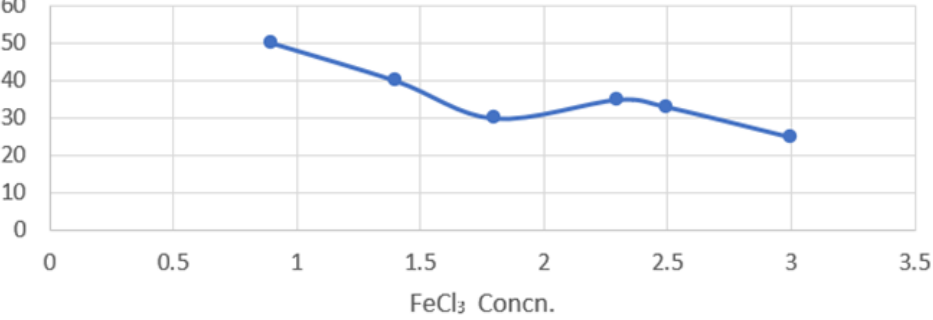
Figure 1. Effect of the concentration of the FeCl 3 inhibitor (g/L) on the An/AAc grafting degree on the PP films. 30% methanol and 70% H 2 O were used as the solvent in a nitrogen system. The comon- omer concentration was 20% by wt% and the comonomer composition was 50:50 by wt% at an irra- diation dose of 20 KGY.